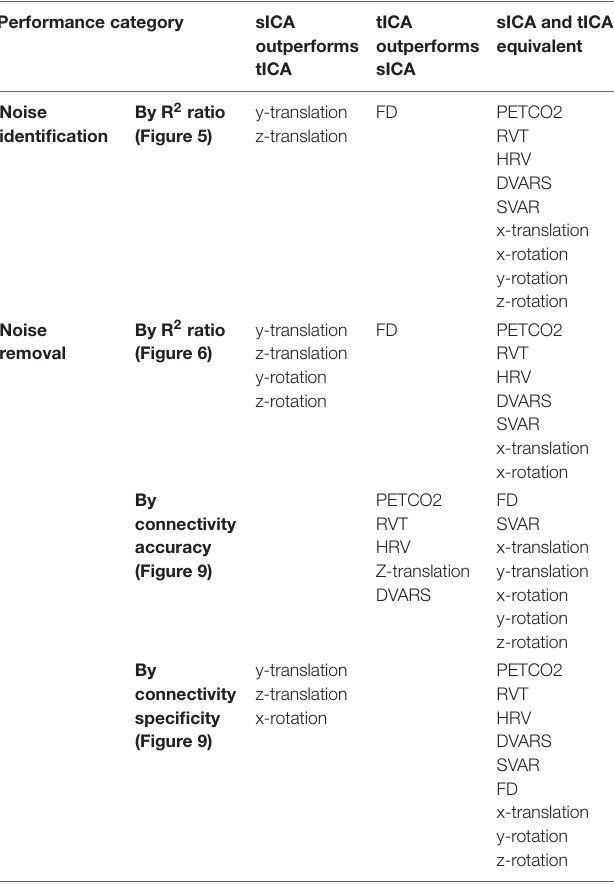
TABLE 2 | Summary of performance of sICA vs. tICA for various noise markers. Performance